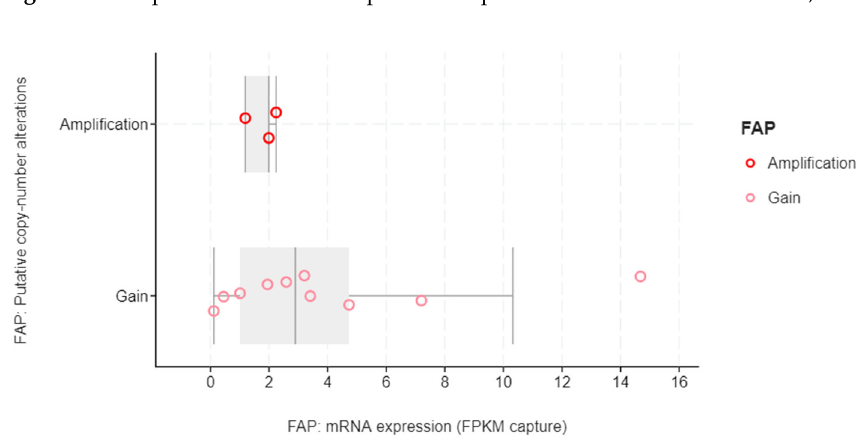
Figure 1. Oncoplot of FAP mRNA expression in patients with mCRPC. #: number, *: % of profiled.